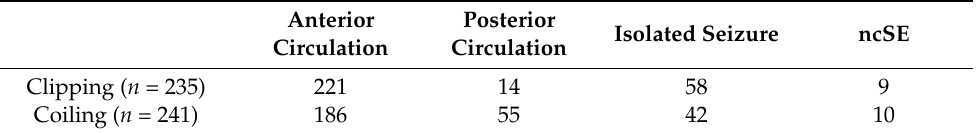
Table 5. Clipping vs.